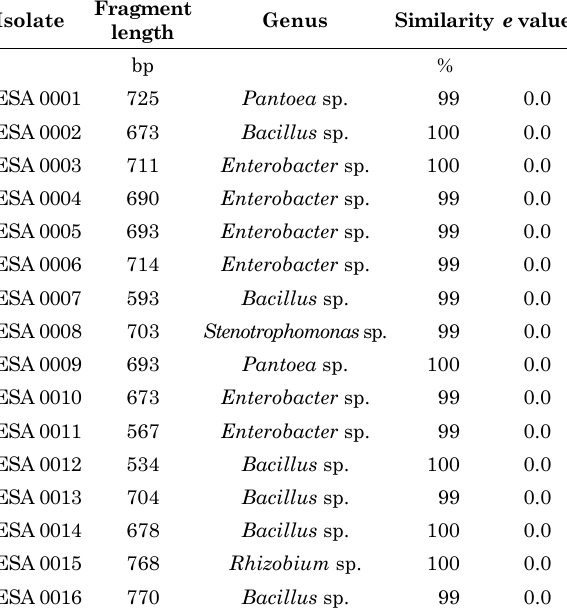
Table 1. Identification of 16 bacterial isolates from Tripogon spicatus by comparison of its partial 16s rRna gene sequence with the sequences available in the Genbank